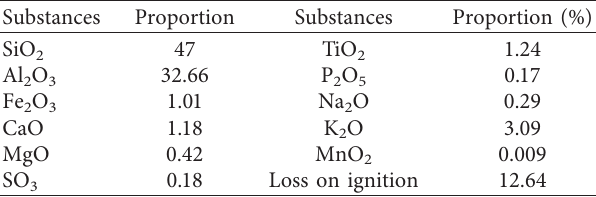
Table 1: Physical composition of coal gangue.